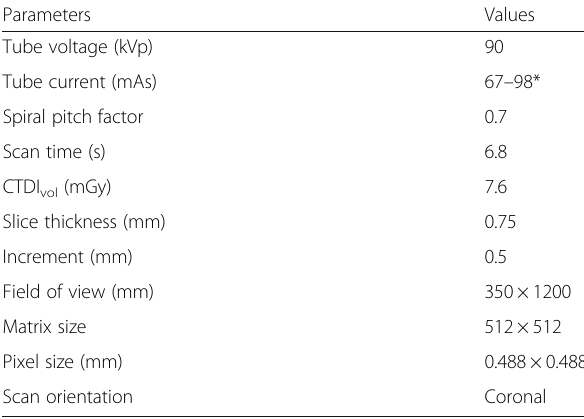
Table 1 Scan protocol and reconstruction parameters using a dual-source computed tomography scanner